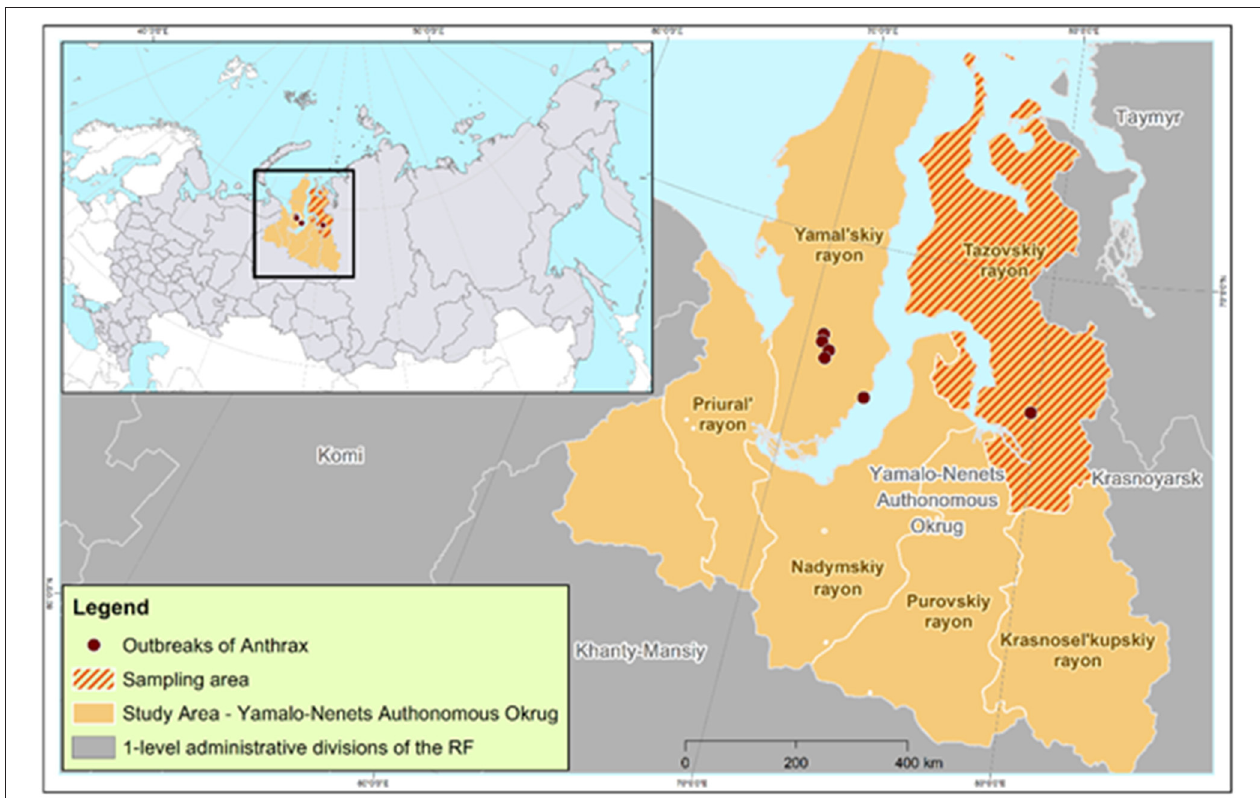
FIGURE 1 | Study area, anthrax outbreaks in 2016, and the area of anthrax immunity monitoring in reindeer.